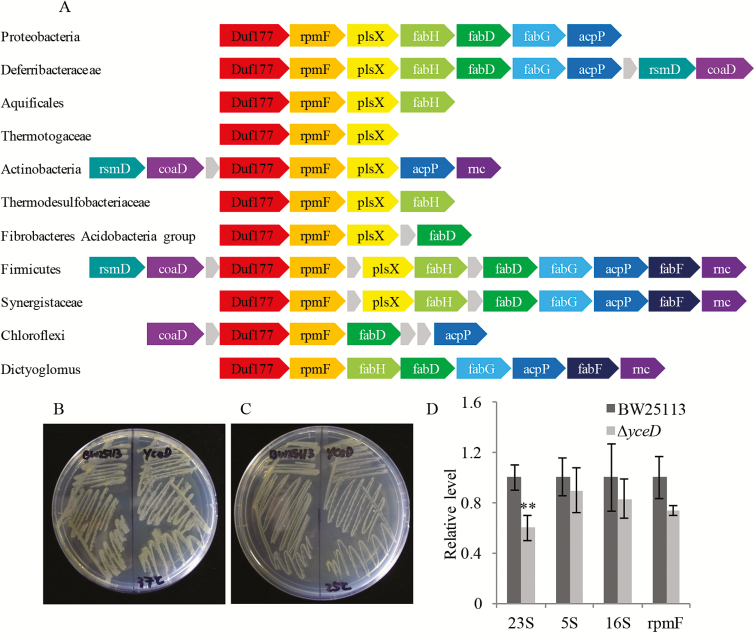
Association between bacterial DUF177 and prokaryotic ribosomes. (A) Bacterial DUF177 genes function in a conserved operon. An association with ribosomal protein L32 (rpmF) and fatty acid biosynthetic genes is conserved in diverse groups of bacteria. plsX, fatty acid phospholipid synthesis protein; fabH, 3-oxoacyl-[acyl-carrier-protein] synthase III; fabD, malonyl CoA-acyl carrier protein transacylase; fabG, 3-oxoacyl-[acyl-carrier-protein] reductase; acpP, acyl carrier protein; fabF, 3-oxoacyl-[acyl-carrier-protein] synthase II; rsmD, ribosomal RNA small subunit methyltransferase D; rnc, ribonuclease III. Gray arrows represent either genes less conserved in a gene cluster or genes encoding uncharacterized proteins. Data are from the STRING database (Szklarczyk et al., 2015). Growth of the
ΔyceD mutant is comparable with that of the BW25113 (wild-type) at 37 °C (B) and 25 °C (C). (D) Relative accumulation of bacterial ribosome 23S, 5S, and 16S rRNAs and the relative expression of the rpmF gene in the wild-type (BW25113) and
ΔyceD mutant. **P<0.01. Error bars indicate the SEM of three biological replicates.